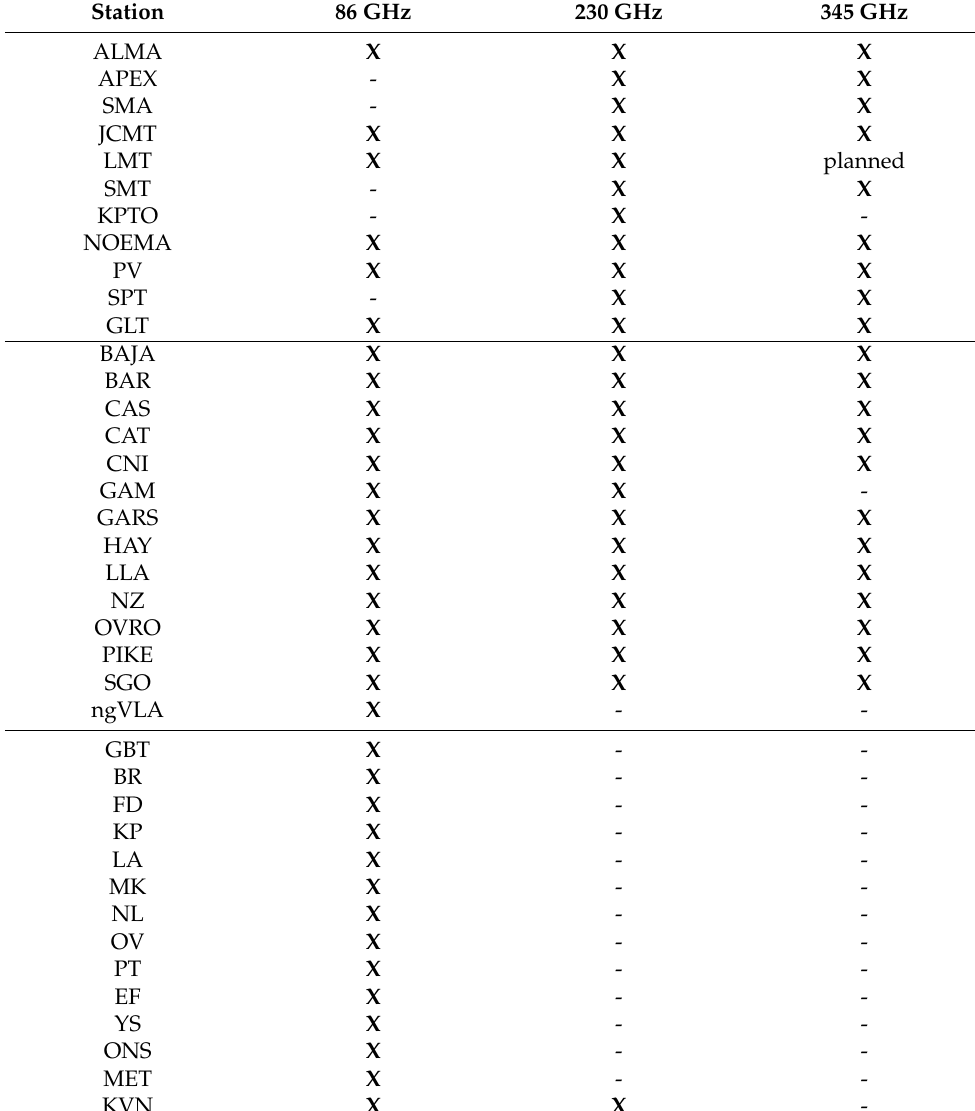
Table 2. Station overview and receiver capabilities, showing which sites are capable (or expected to be capable) of observing in which frequency